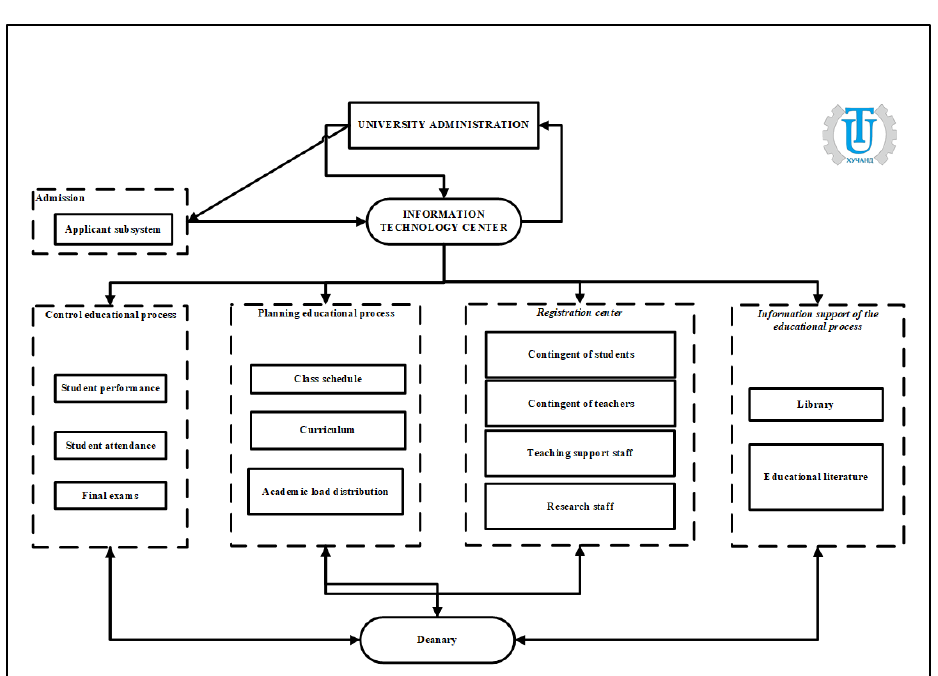
Fig. 1. Conceptual model of KPITTU